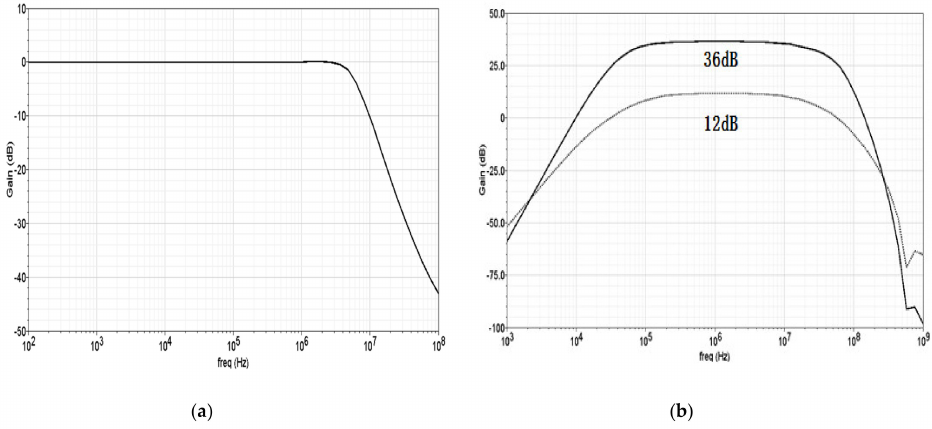
Figure 8. ( a ) The simulated AC response of the LPF. ( b ) The simulated AC response of the programmable gain amplifier (PGA) in di ff erent gain modes.